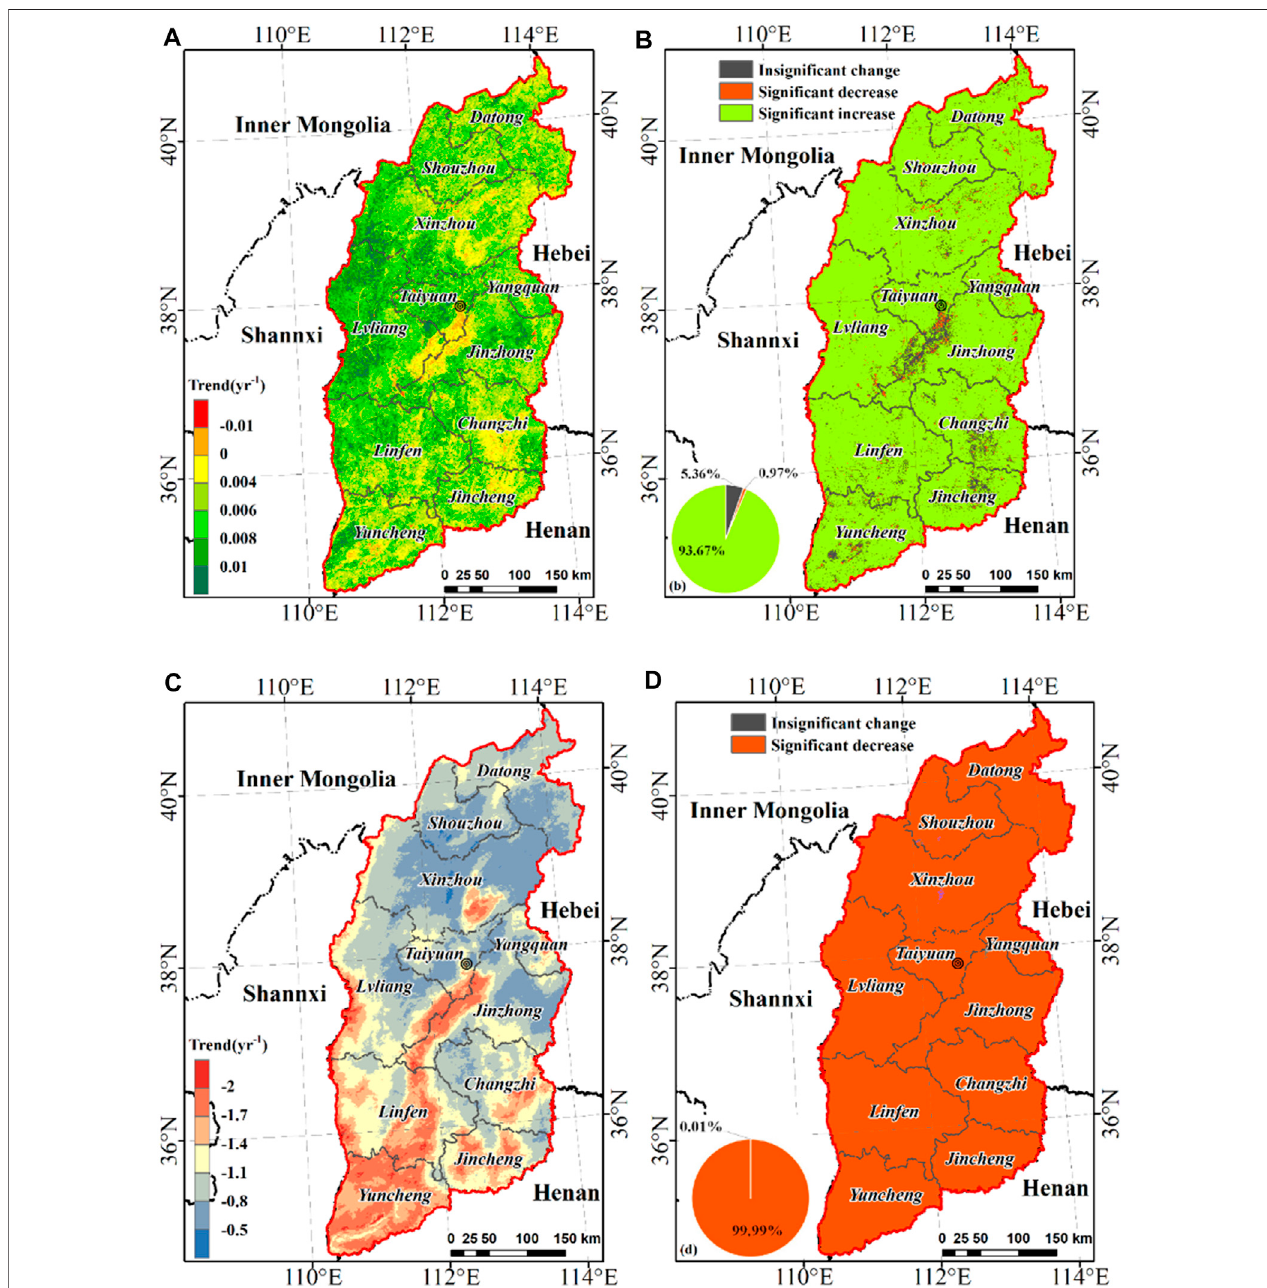
FIGURE 5 | Difference in the NDVI change trend (A,B) and PM 2.5 trend (C,D) in Shanxi Province from 2001 to 2020.